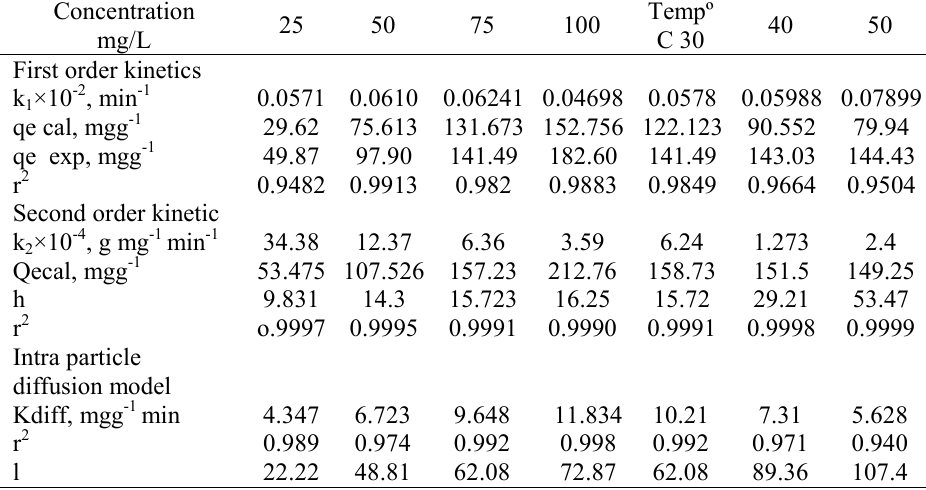
Table 2. Calculated kinetic parameters for the adsorption of AG 25 onto ACC at various concentrations and